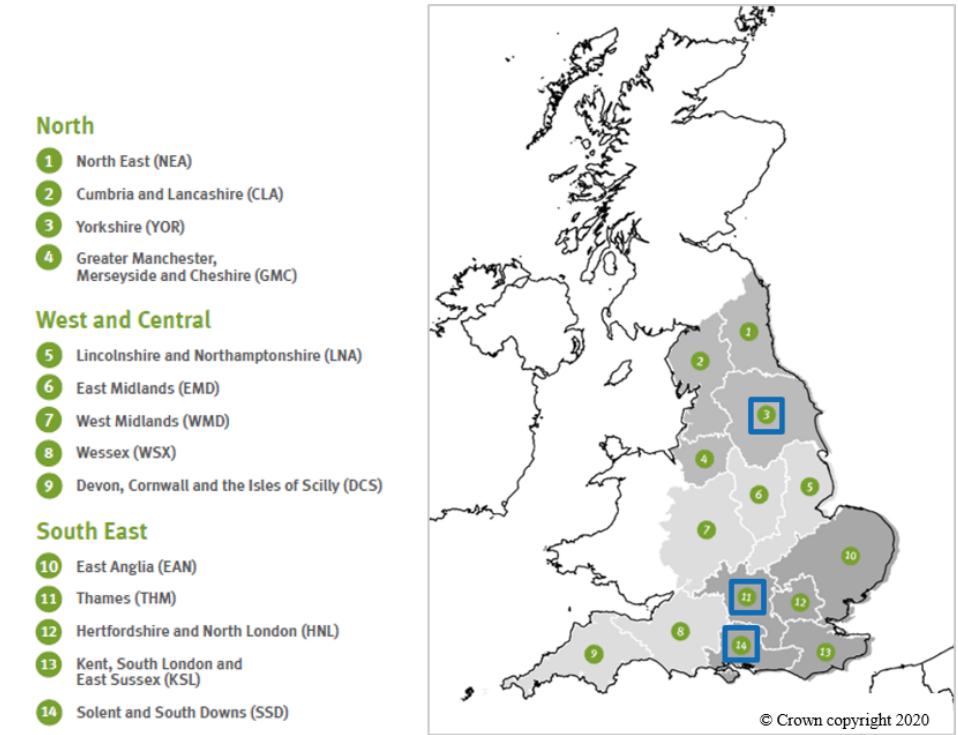
Figure 1. Map showing the geographical areas of the EA’s operations (green numbered areas), highlighting the three areas which the centres where interviews were carried out are responsible for (blue boxes) (source: